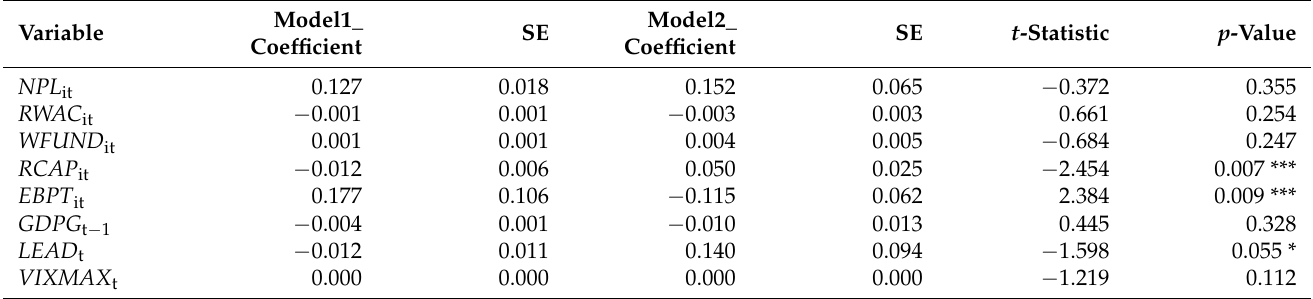
Table A7. Comparison of pre-crisis (adjusted) (2) and crisis (adjusted) (4).